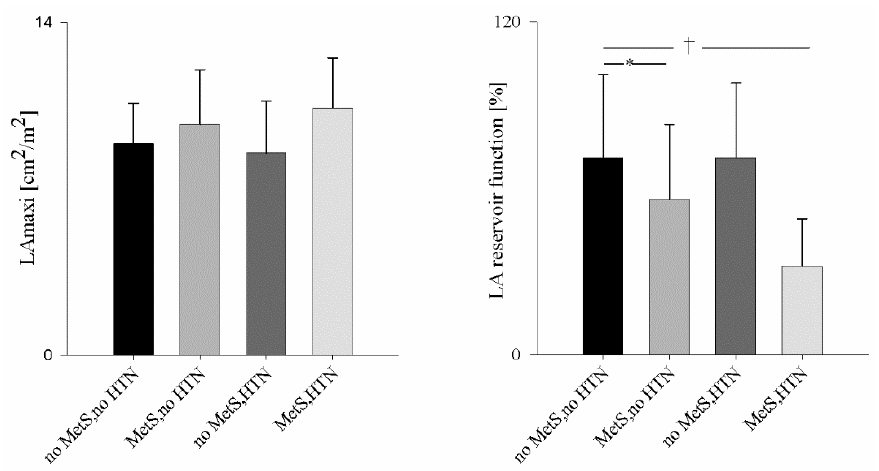
Figure 4. Left panel: Comparison of indexed monoplane 4-chamber maximal left atrial area (LAmaxi) in subjects without Metabolic Syndrome (no MetS) and normotensive (no HTN) (black bars), subjects with MetS and no HTN (grey bars), subjects no MetS but hypertensive (HTN) (dark grey bars), and subjects with MetS and HTN (light grey bars); right panel: comparison of LA reservoir function in no MetS and no HTN (black bars), MetS and no HTN (grey bars), no MetS but HTN (dark grey bars), and MetS and HTN (light grey bars); * p < 0.001, Mets, no HTN vs. no MetS, no HTN; † p < 0.001, MetS, HTN vs. no MetS, no HTN.